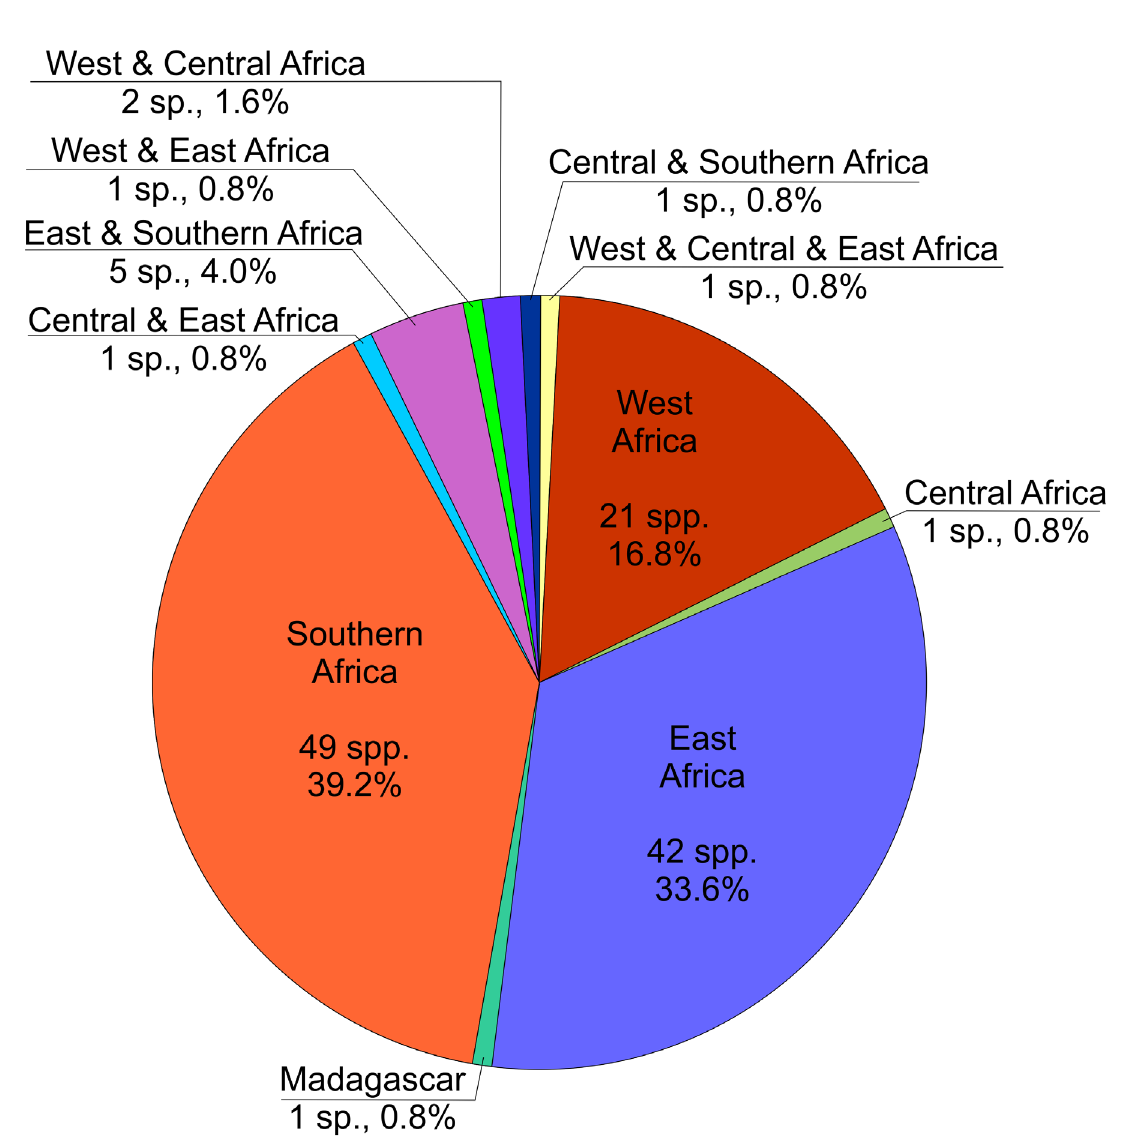
Fig. 201. Proportions of aelurilline species in different subregions of